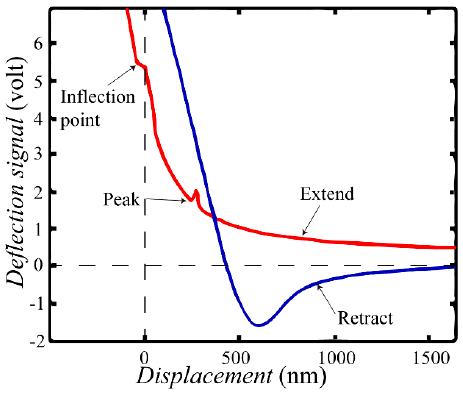
Figure 4. The original data curve unable to process.